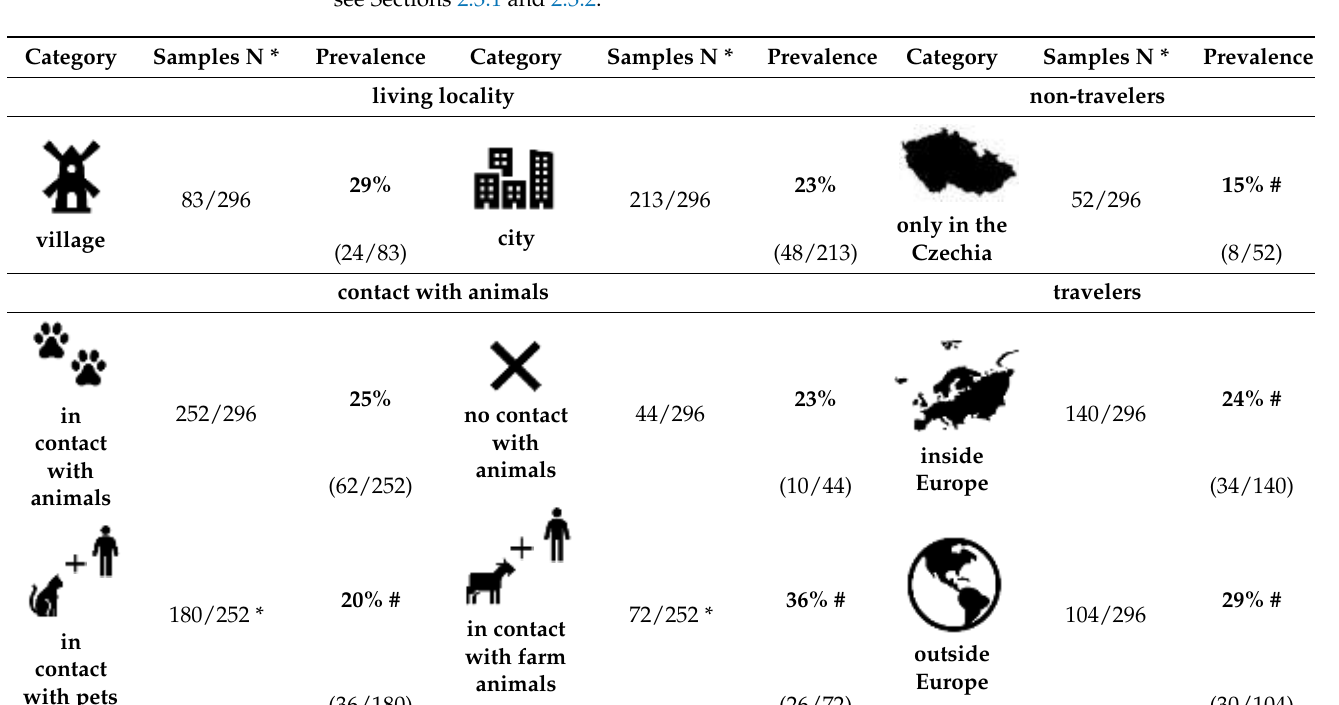
no contact with animals